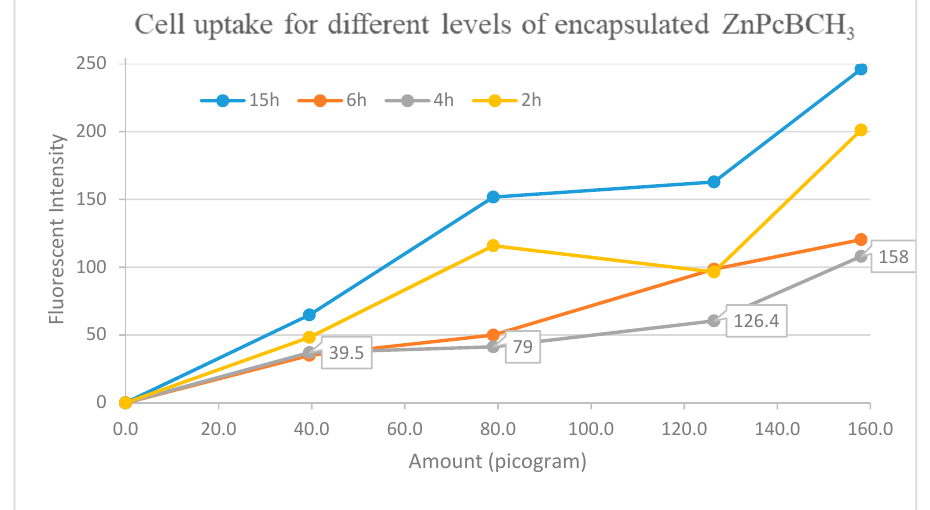
Figure 8. A549 cell uptake of encapsulated ZnPcBCH 3 at different incubation times and nanoparticle dye levels. The boxed numbers on the graph indicate the specific amounts of encapsulated ZnPcBCH 3 added. Higher fluorescence intensity (616 Ex /700 Em ) indicates higher cell uptake of the encapsulated ZnPcBCH 3 .